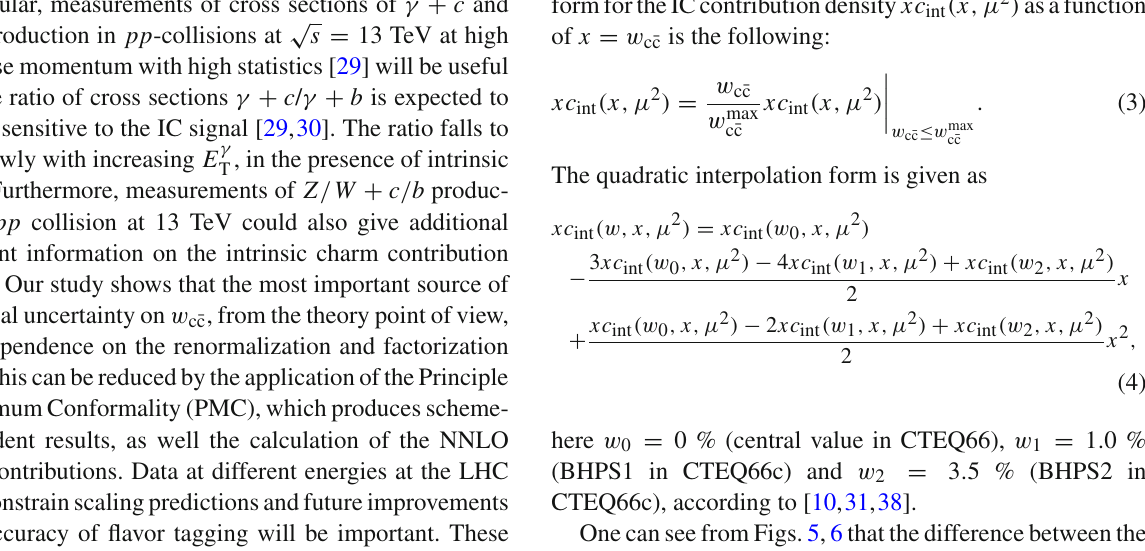
ability in the proton at 1.93% with 68% CL. In order to